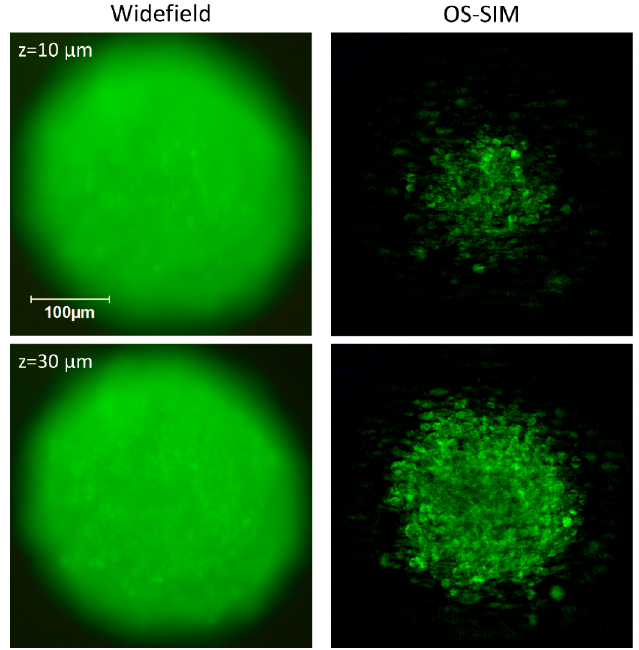
Figure 5. Spheroid of CHO-pAcGFP1-Mem cells. Conventional wide-field ( left ) and OS-SIM images ( right ) at different depths within the spheroid. While conventional wide-field microscopy includes a large amount of out-of-focus information, OS-SIM selects focal planes and resolves single cells. It should be added that Structured Illumination Microscopy can also be used for su- per-resolution imaging with a 2-times enhancement of resolution in comparison with the Abbe criterion. In contrast to OS-SIM, “SR-SIM” [52,53]) is based on a coherent superpo- sition of two or three laser beams modulated by an optical grid at different angles and phase positions. However, this technique is commonly limited to thin samples, as out-of- focus light degrades the quality of the grid pattern in the sample plane. In addition, ac- quisition of multiple (typically 9–15) raw images needed to reconstruct a single super- resolution frame takes relatively long time and thus reduces acquisition speed. These lim- itations can be overcome by illuminating the sample with a lattice pattern rather than grid lines, which gives higher contrast and allows a more robust image reconstruction [54,55]. Light Sheet Fluorescence Microscopy (LSFM) is another wide-field method that uses optical sectioning with the sample being illuminated from the side (at 90° with respect to the microscope axis) by either a cylindrical lens or scanning of a laser beam. For 3D imag- ing, the light sheet and the microscope objective lens used for detection can be shifted simultaneously in axial direction, so that the illuminated part of the sample is always in the focus of the objective lens. Both shifts may be different due to the refractive index of the immersion fluid, but this can be corrected either mechanically [56] or by software. Alternatively, the sample can be moved in axial direction through a static light sheet. Thus, z-stacks can be recorded with low fluorescence background and high contrast, as depicted in Figure 6 for spheroids of MCF-7 breast cancer cells incubated with the cyto- toxic drug doxorubicin. A 3D image can be calculated offline from these images, as de- scribed elsewhere [57]. The main advantage of Light Sheet over OS-SIM is that only those planes are illuminated, which are recorded simultaneously, so that light exposure is con- siderably lower than for those methods, where recording of each image requires illumi- nation of the whole specimen. Commercial light-sheet microscopes (e.g., Carl Zeiss, Olym- pus, Nikon) as well as open-source solutions or add-ons for existing microscopes are pres- ently available [56,58].